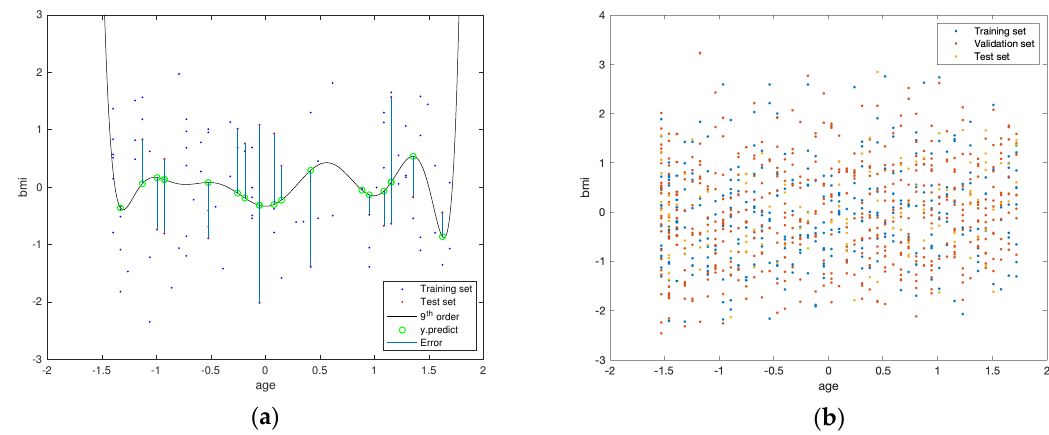
Figure 4. ( a ): Graphs of the 9th polynomial regression with 100 data ( b ): Plot of 1000 data sets for use in training set, test set, and validation set divided by 6:2:2.